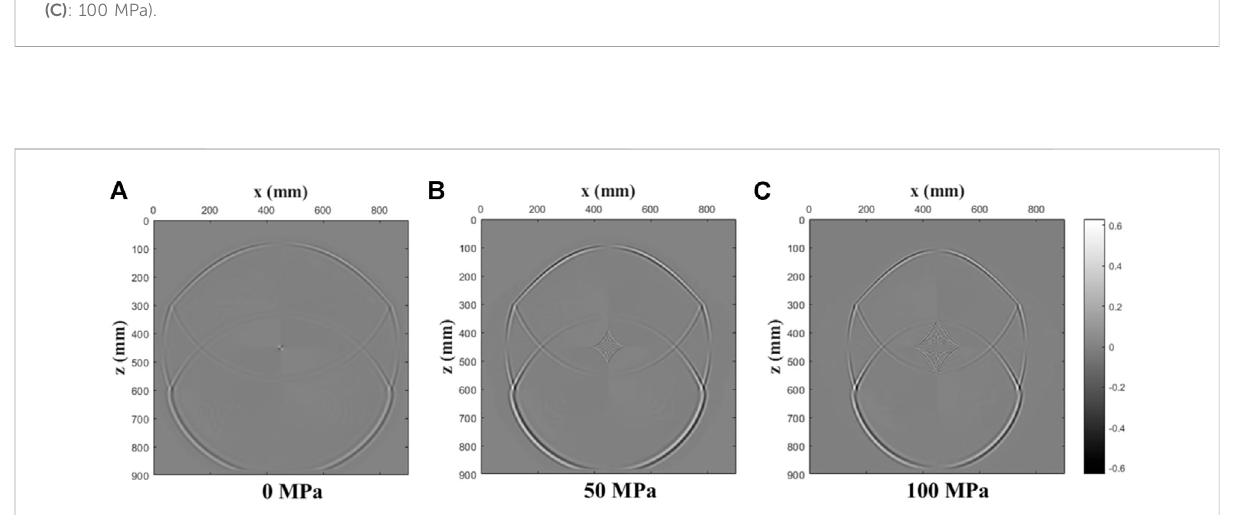
FIGURE 19 Decoupled P-wave fi eld snapshots of the x -component at t = 0.1 ms for a three-layer model under various uniaxial stresses ( (A) : 0 MPa; (B) : 50 MPa; (C) : 100 MPa).